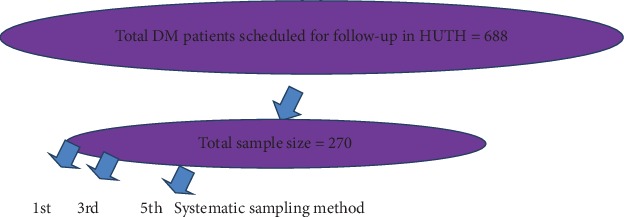
Schematic representation of sampling procedure.